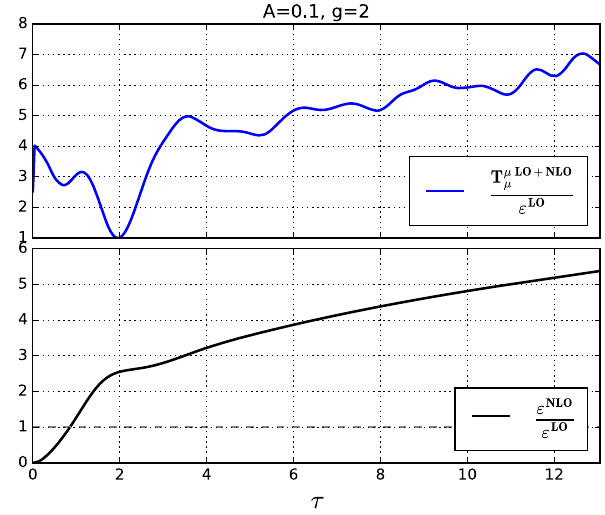
Fig. 3 The same as for Fig. 1 but with A